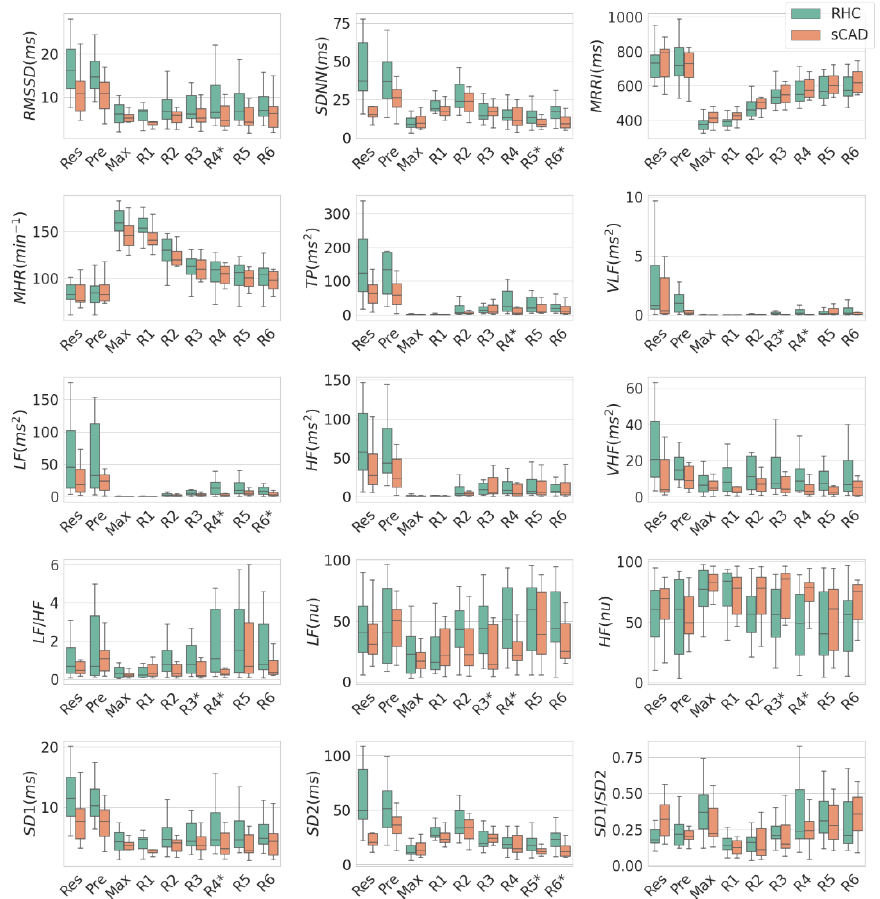
Figure 1. The box plot of time- and frequency-domain HRV indices of the sCAD and the RHC groups at rest, maximum heart rate, and recovery stage (R1~R6). The symbol * indicates a significant difference at the 0.05 level ( p < 0.05).